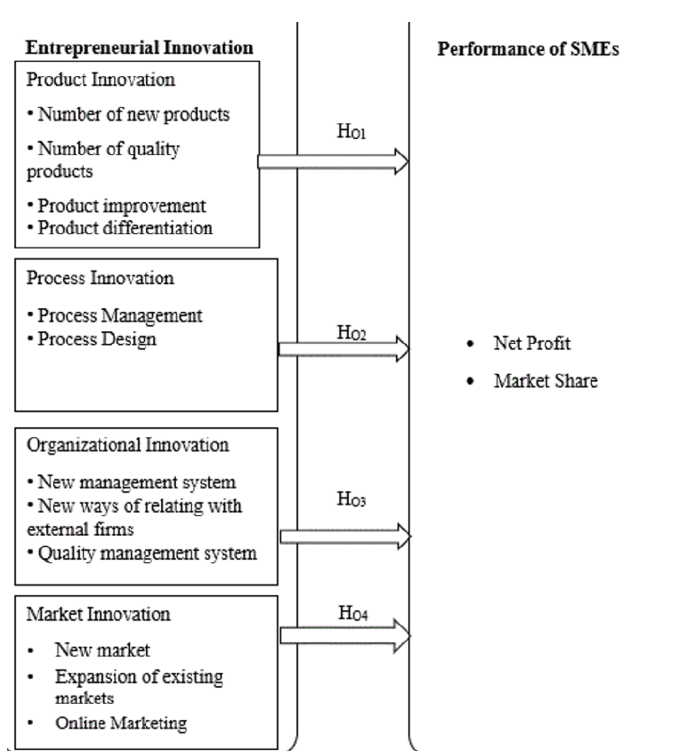
Figure 1: Research Model; Source: Dushime et al.